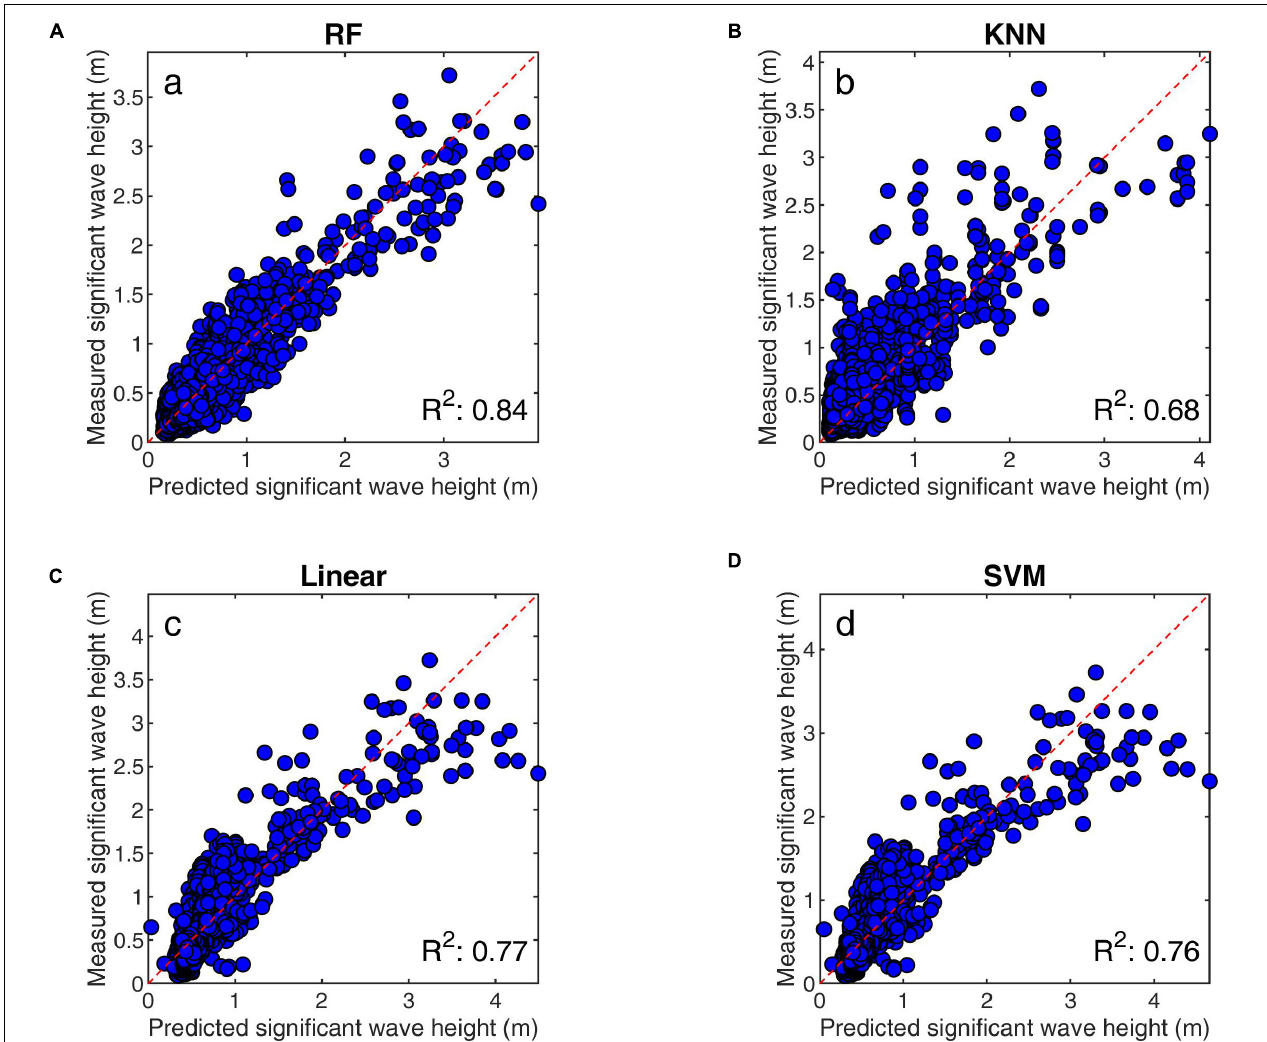
FIGURE 14 | Scatter plots showing the measured versus the predicted significant wave heights of the Cetraro buoy from 1 September to 31 December 2014. The prediction was carried out by RF regression (A) , KNN regression (B) , linear regression (C) , and SVM regression (D) . The red dashed line in (A–D) is the y = x line. The value of the determination coefficient ( R 2 ) is also reported in the bottom right corner of the